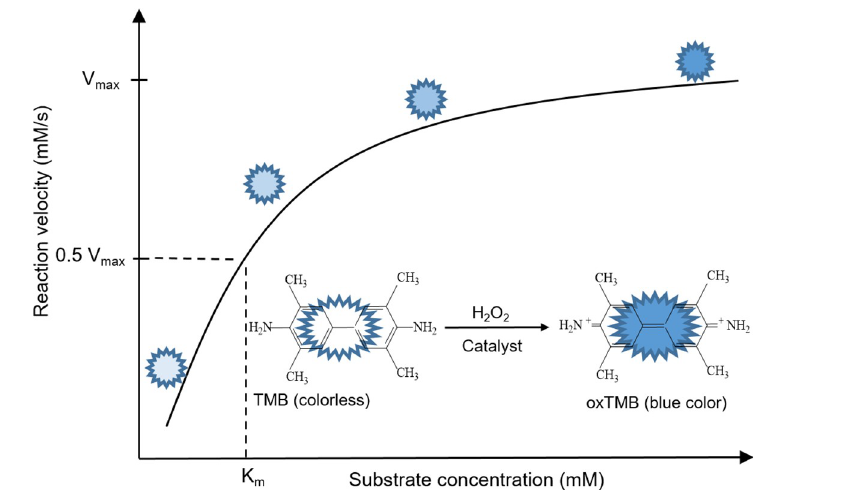
Fig 1. Kinetic curve for peroxidase-like reaction using TMB as a